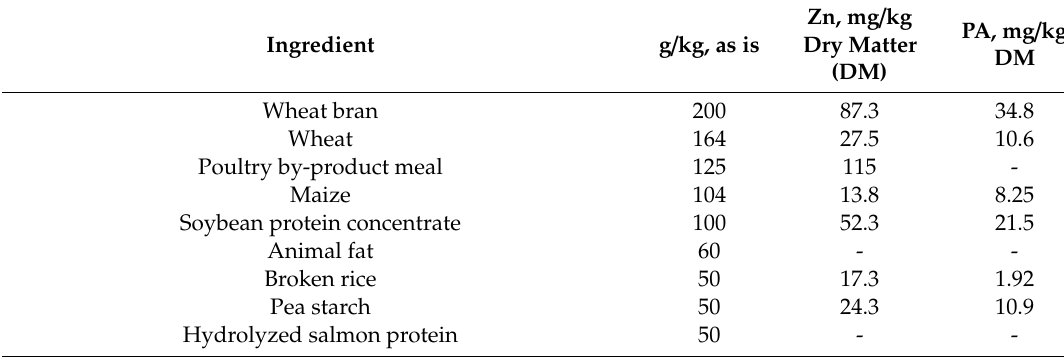
Table 1. Ingredient composition of the studied diets and zinc and phytic acid (PA) contents of individual ingredients of the four experimental